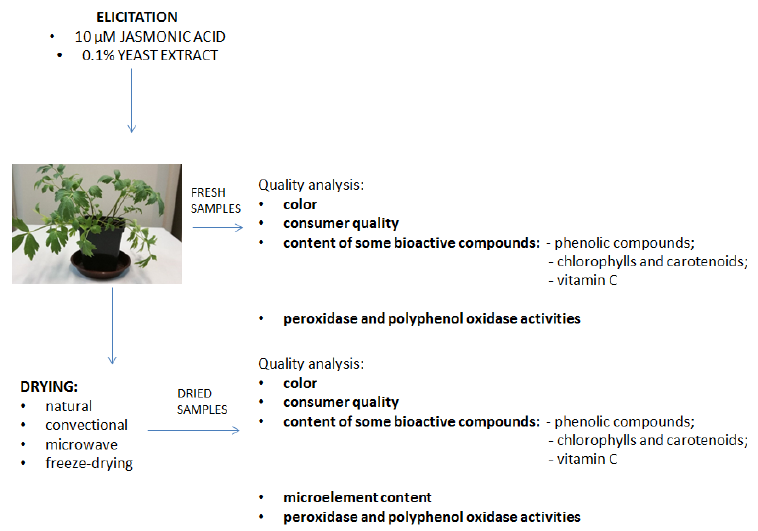
Figure 1. Scheme of the experimental procedure.